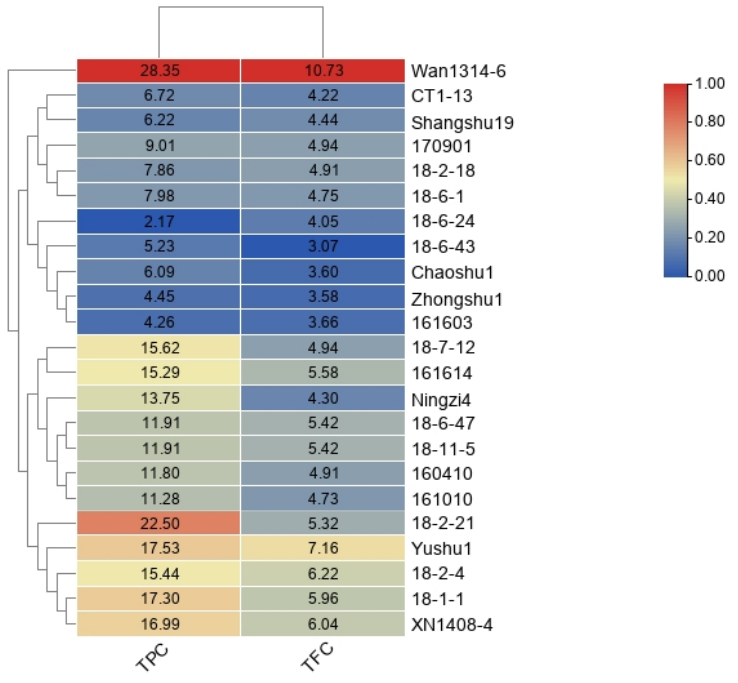
Figure 2. Heatmap of TPC and TFC of blades from 23 sweetpotato genotypes. Note: The values in the figure are the measured TPC or TFC values. Heatmap production with reference to the maxi- mum value of each column. TPC: total polyphenol content; TFC: total flavonoid content. value of each column. TPC: total polyphenol content; TFC: total flavonoid